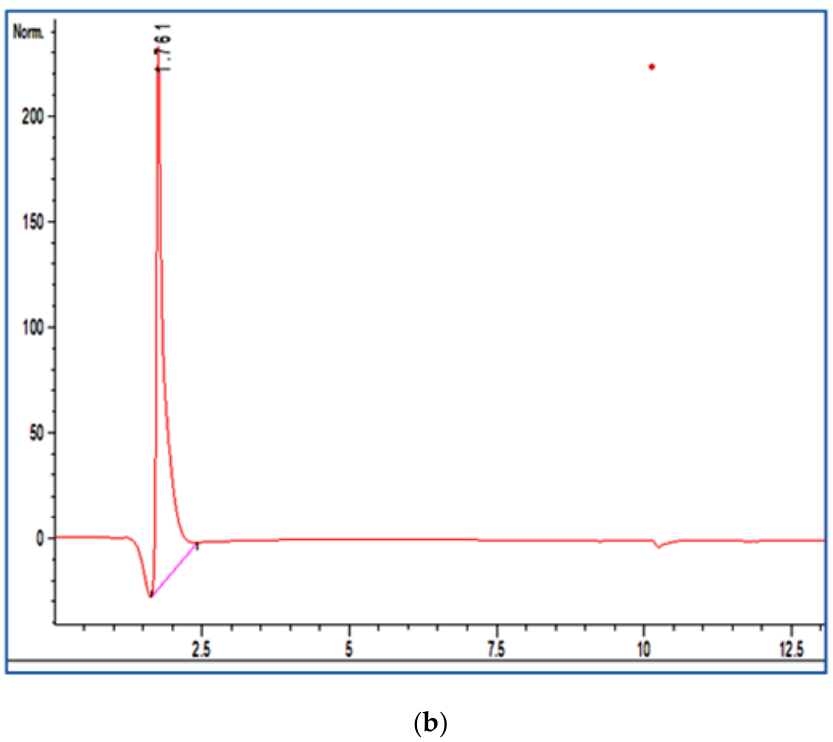
Figure 1. HPLC chromatograms corresponding to ( a ) Bcs (Bc1 and Bc2) and ( b ) Bx of the aqueous extract of beetroot peel (BPE).